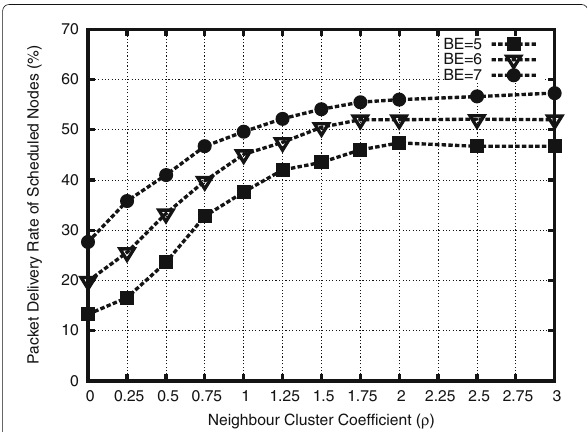
Fig. 10 Blocking rate of uncoordinated nodes with CA and DUD algorithms, for K = 100, M = 100, and different values of CCA thr